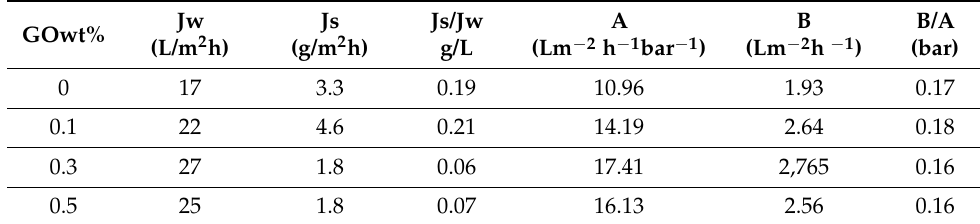
Table 2. Permeation properties of fabricated membranes.